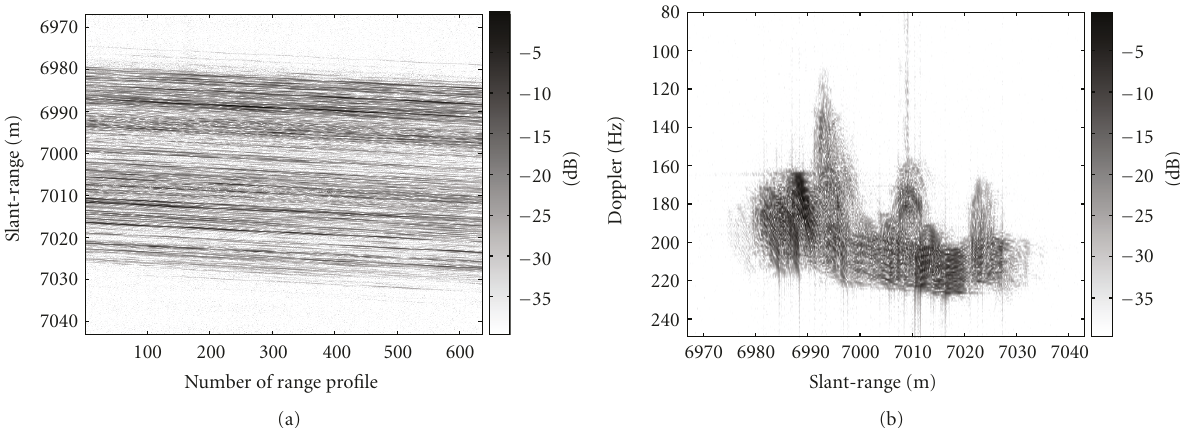
Figure 14: (a) Range profiles and (b) ISAR image for the real data of the vessel without compensating the translational motion.